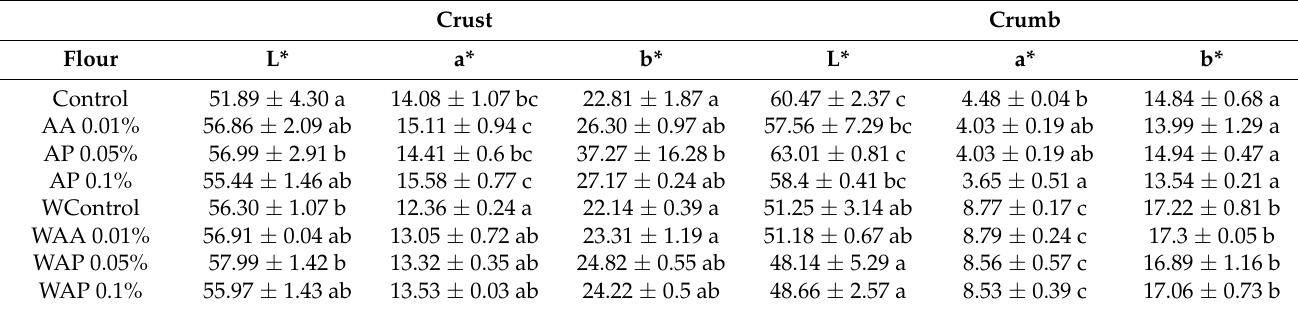
Table 4. Bread crust and crumb